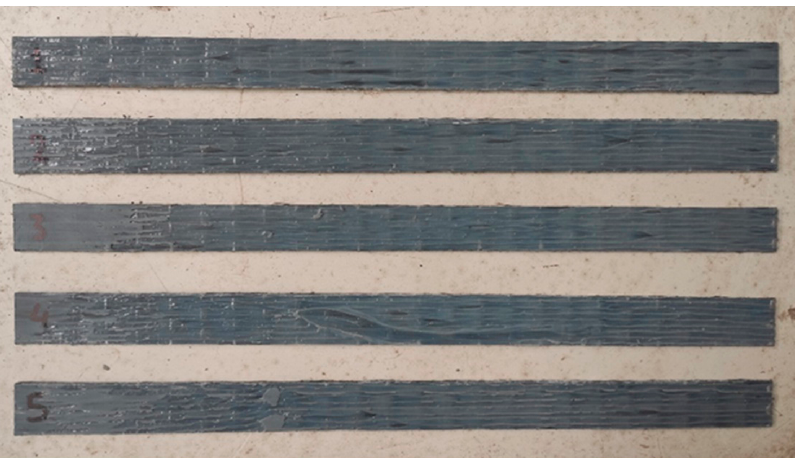
Figure 1. Investigated specimens (MRT-MF_1; t = 1.63 mm, b = 15.74 mm, MRT-MF_2; t = 1.74 mm, b = 17.26 mm, MRT-MF_3; t = 1.71 mm, b = 14.68 mm, MRT-MF_4; t = 1.65 mm, b = 16.56 mm, MRT-MF_5; t = 1.78 mm, b = 15.95 mm).